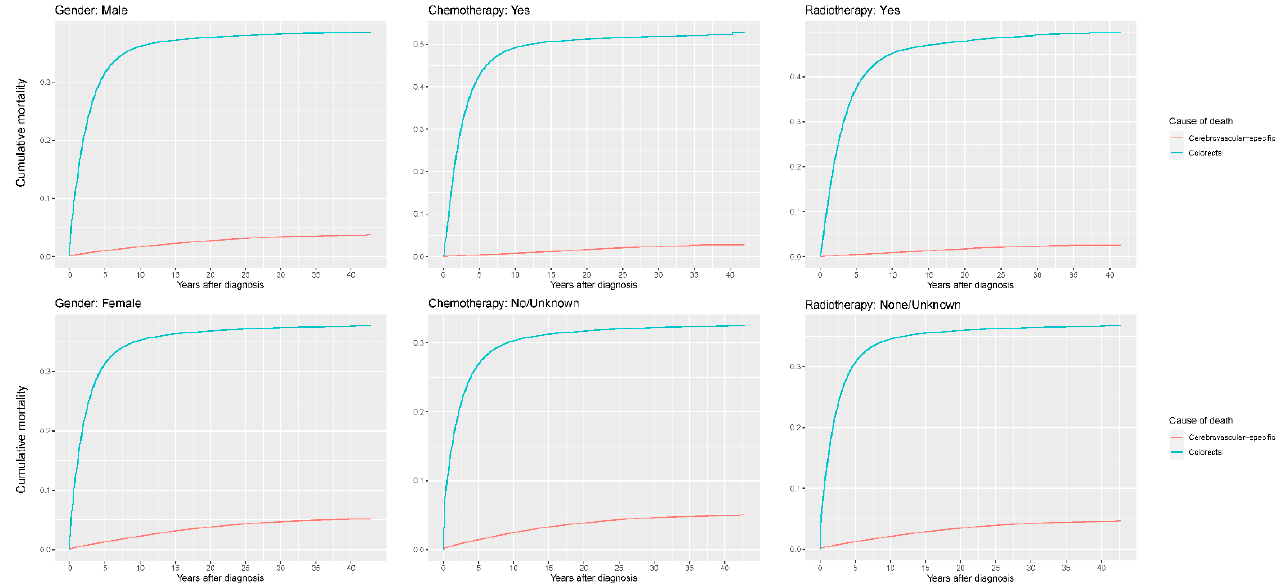
Figure 6. Cumulative cerebrovascular-specific and colorectal cancer-specific mortality stratified by gender, chemotherapy and radiotherapy. Univariate analyses using a competing risk model were performed to test the relationship between the clinical factors and CVSM in CRC patients ( p < 0.0001), and differences in cumulative mortality among different subgroups were analyzed by Gary’s test.